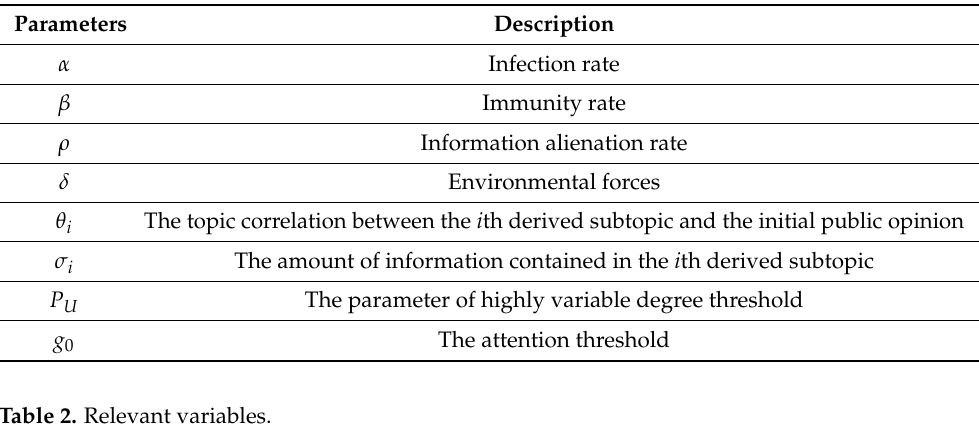
Table 1. Relevant parameters.